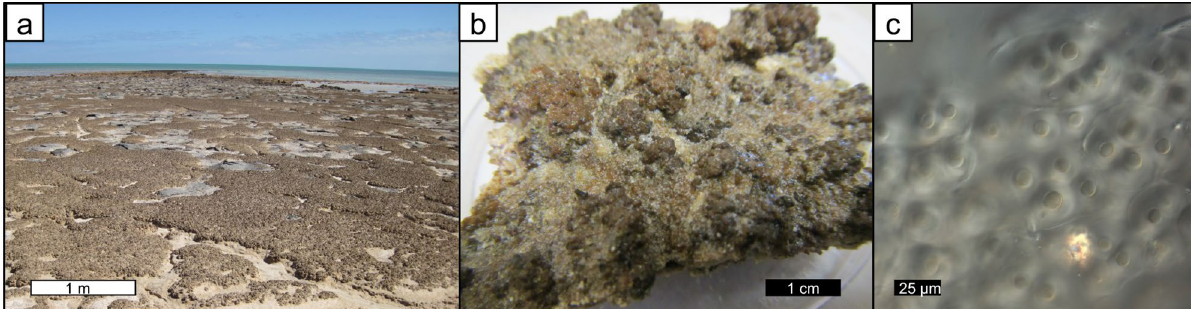
Figure 2. Unlithified pustular sheet mats dominated by Entophysalis . ( a ) Pustular sheet mats in the upper intertidal zone around the margin of Hamelin Pool in the Flagpole Province, scale bar applies to foreground; ( b ) hand sample of pustular sheet mat (HP14-JS21); ( c ) confocal image showing healthy live Entophysalis major cells within EPS